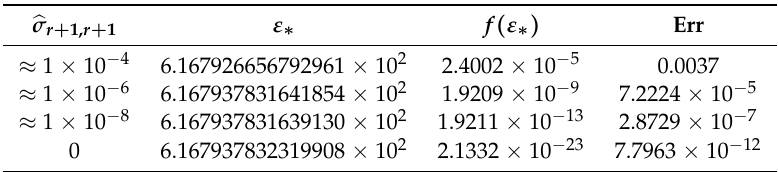
Table 7. Computational results from recovering three matrices of different ranks and 30% of known entries. The dimension is always 1000 ×